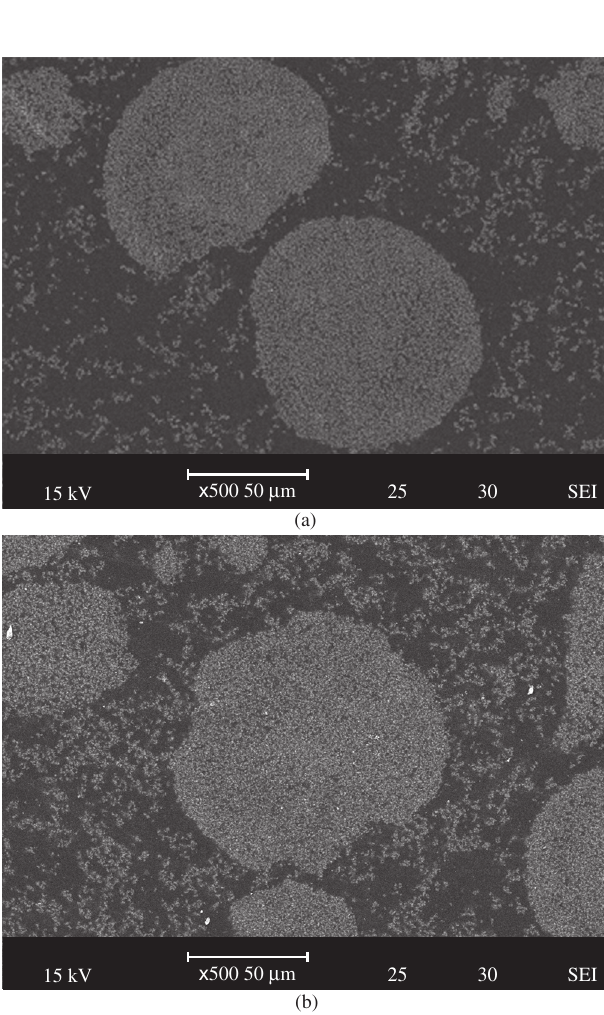
Figure 1. SEM of composites with a) 10 and b) 15 vol (%). Bar 50 µ m.